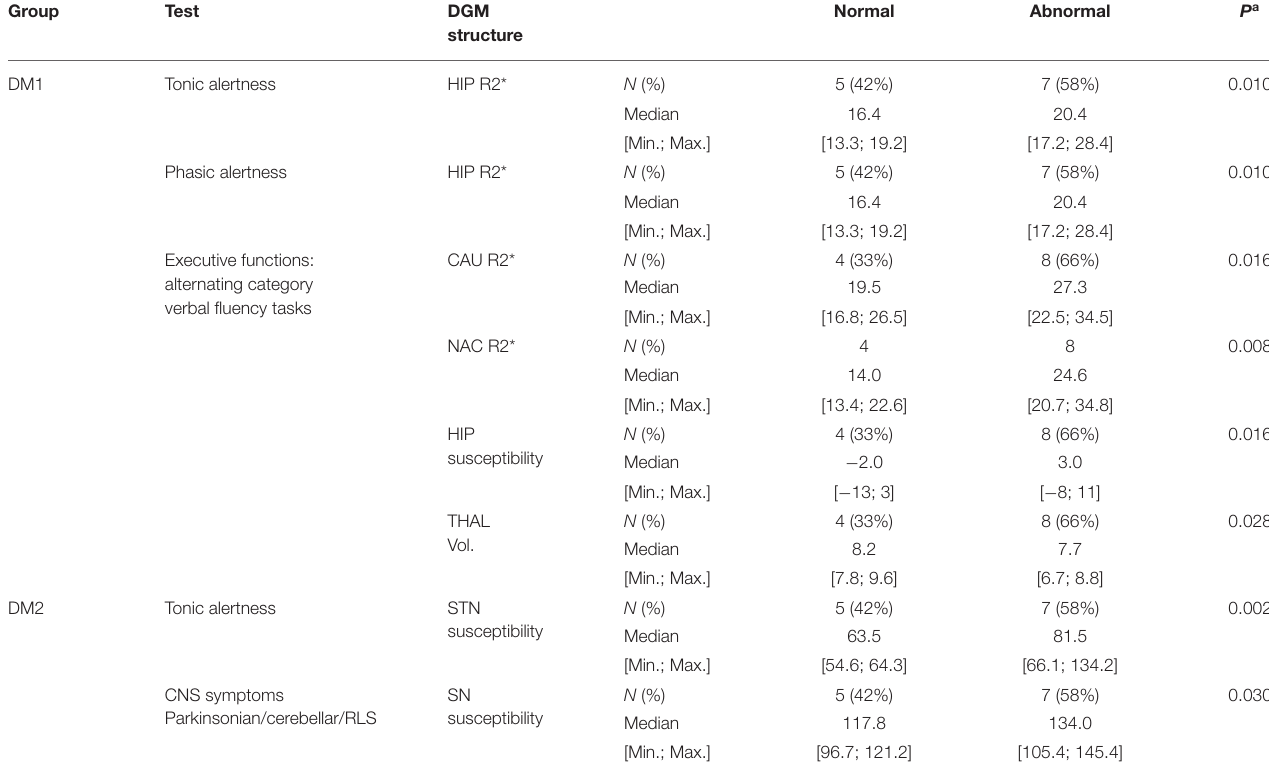
TABLE 7 | Group comparison of R2 * [s − 1 ], magnetic susceptibility [10 − 3 ppm referenced to CSF] and volumes [ml] of the DGM structures between patients with normal and abnormal neuropsychological test results: only significant results with P < 0.050 are reported.